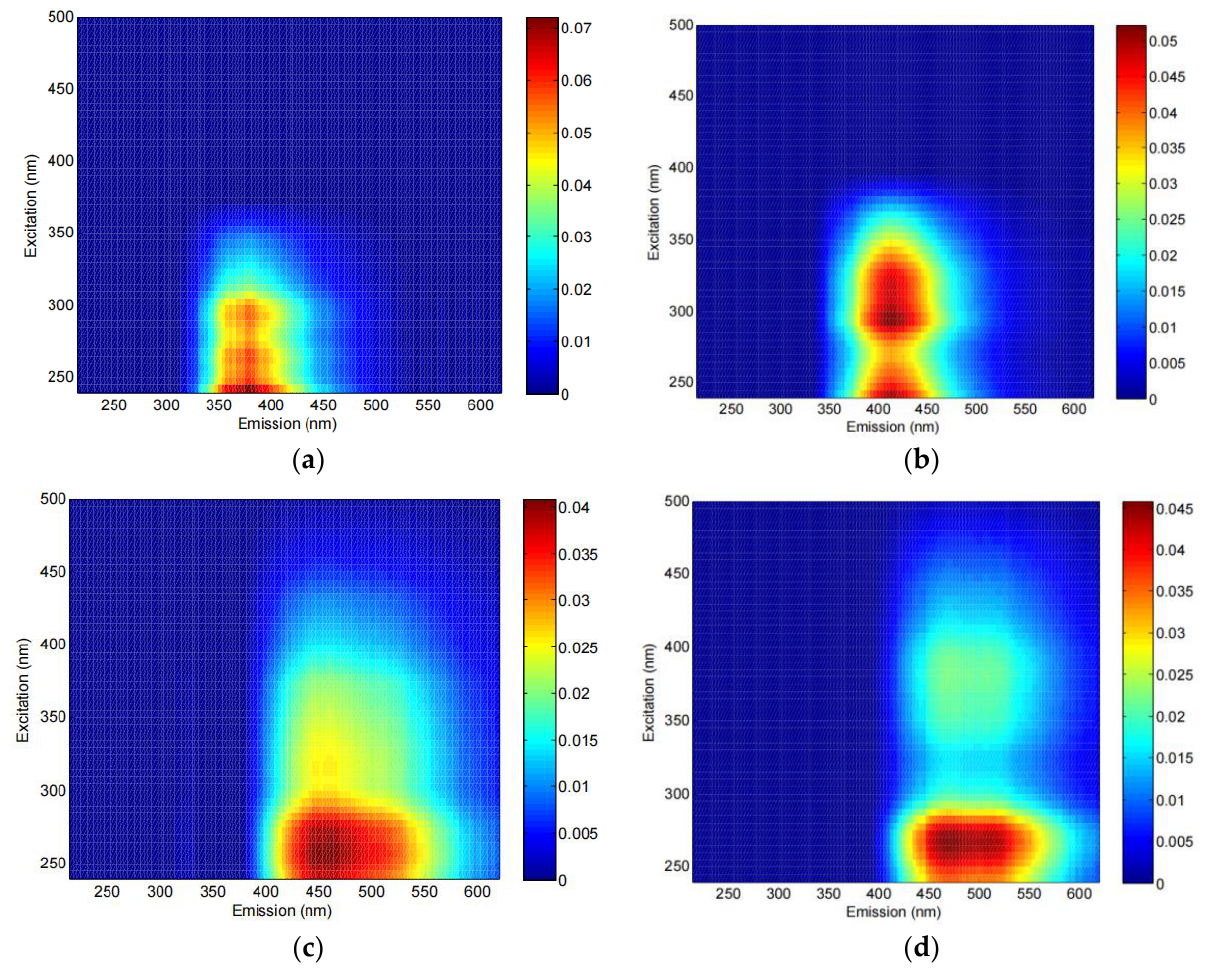
Figure 3. EEM locations, representative EEMs, and spectral loadings of fluorescent components in straw-derived DOM identified by PARAFAC: ( a ) C2 in rice straw amended soils; ( b ) C2 in the maize straw amended soils; ( c ) C3 in the rice straw amended soils; ( d ) C3 in the maize straw amended soils. Values of each EEM spectrum represent all the samples collected across the whole incubation period for a specific straw addition treatment.